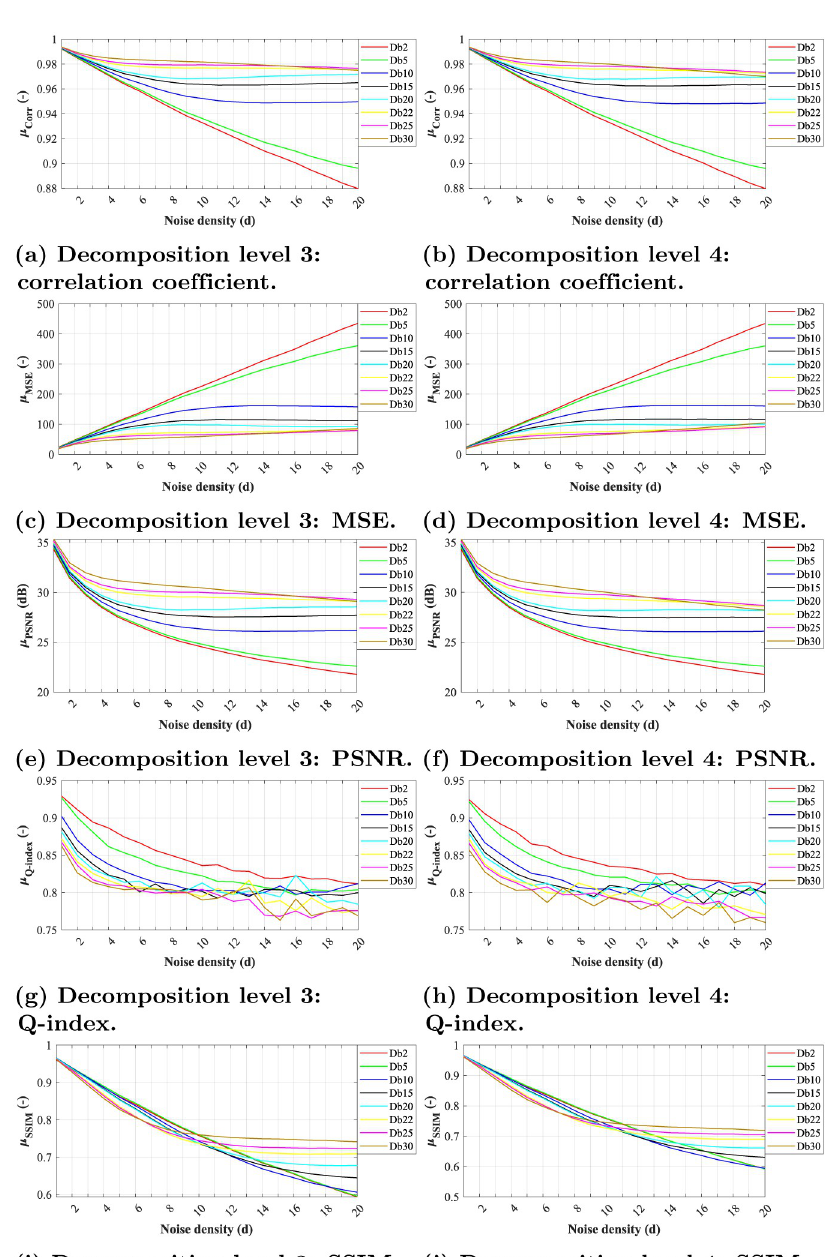
Fig 7. A comparative analysis of Salt and Pepper noise ( d = {0.001, 0.002, ... , 0.02}) for Daubechies wavelets with decomposition level 3 and 4. (a) Decomposition level 3: correlation coefficient. (b) Decomposition level 4: correlation coefficient. (c) Decomposition level 3: MSE. (d) Decomposition level 4: MSE. (e) Decomposition level 3: PSNR. (f) Decomposition level 4: PSNR. (g) Decomposition level 3: Q-index. (h) Decomposition level 4: Q-index. (i) Decomposition level 3: SSIM. (j) Decomposition level 4: